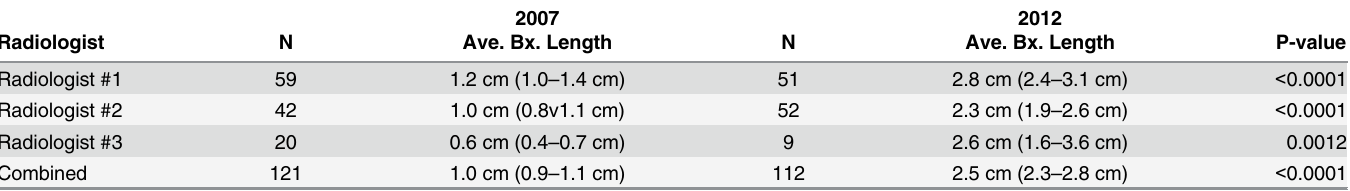
Table 2. Individual Radiologist